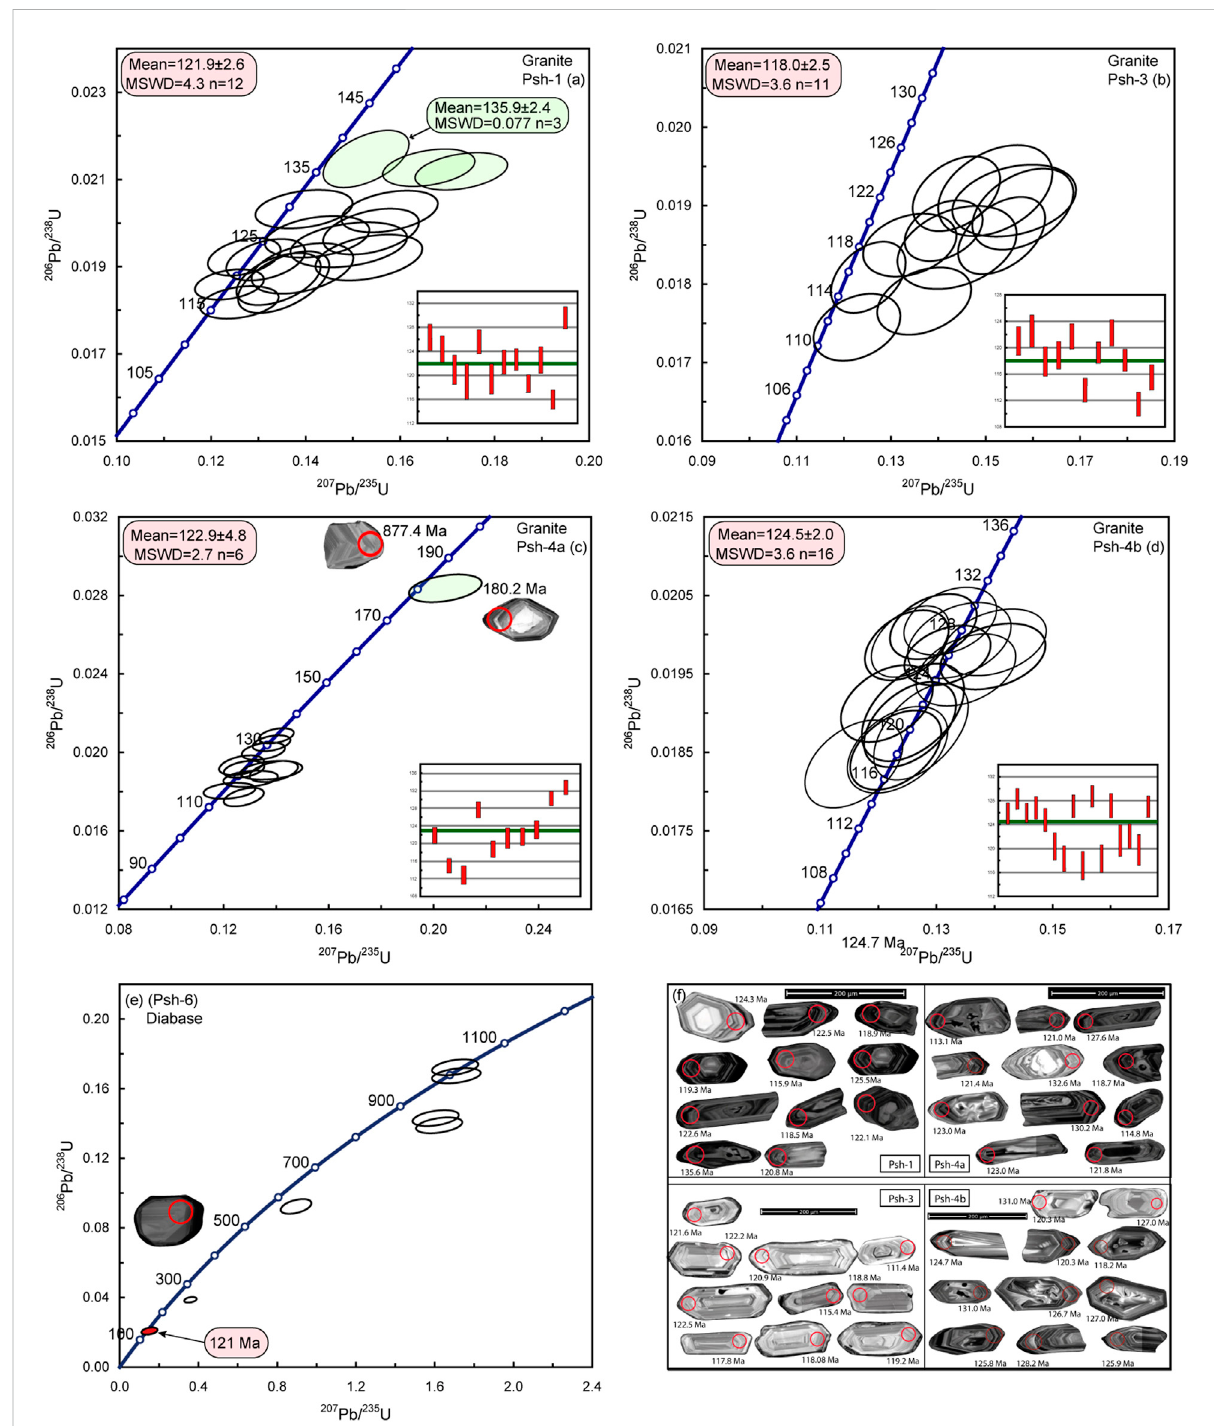
FIGURE 4 (A – D) U – Pb Concordia diagrams of zircons from granites. (E) Diabase dike and (F) CL images of dated granite zircons. MSWD, mean square of the weighted